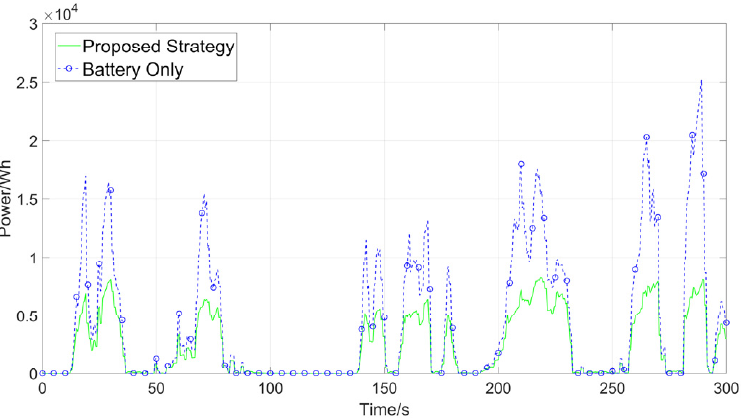
Table 3. Performances Comparison.